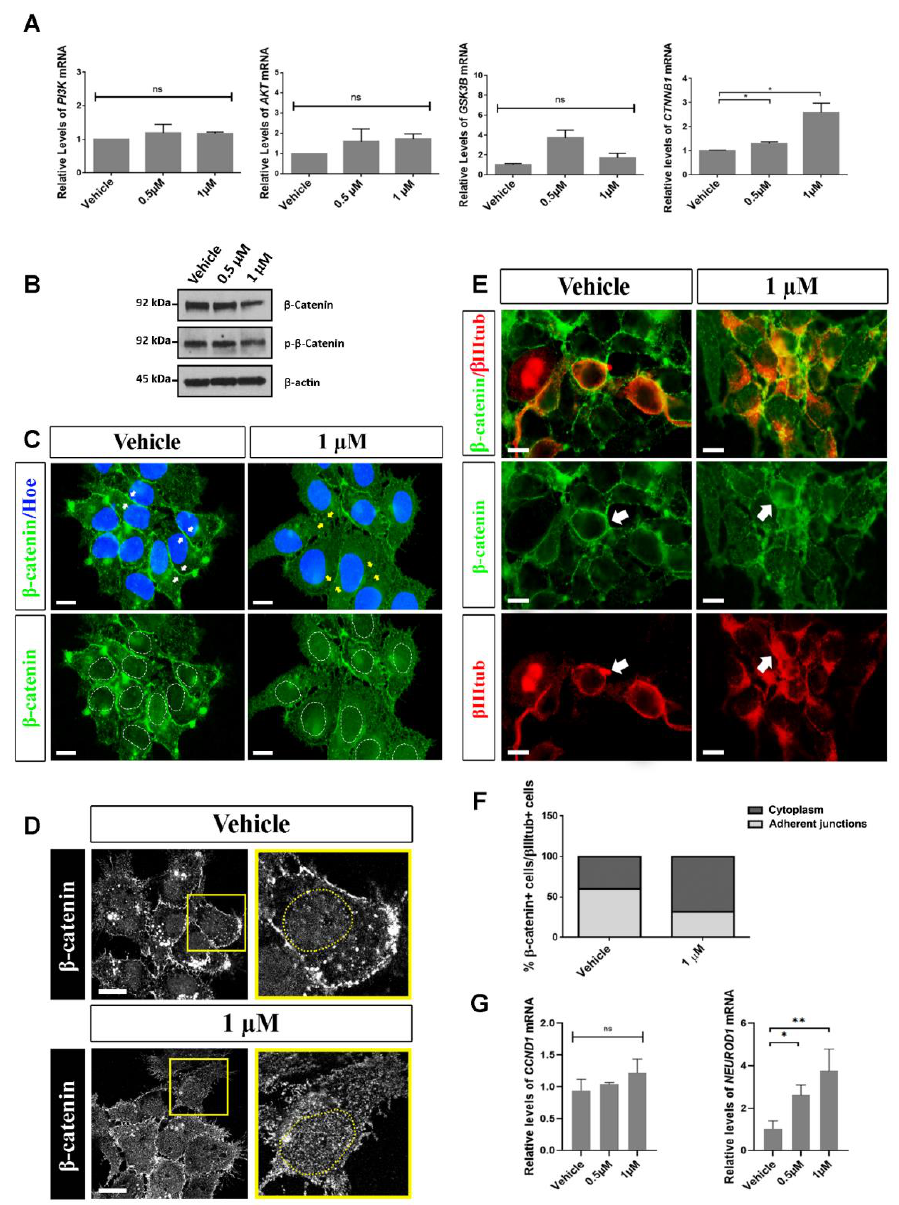
Figure 3. Change in β -catenin localization after treatment with the A β 40 peptide in differentiating hNS1 cells. ( A ) Relative expression levels of PI3K mRNA, AKT mRNA, GSK3B mRNA and CTNNB1 mRNA obtained by RT-qPCR analysis after treatment with the A β 40 peptide. ( B ) WB analysis of the expression of β -catenin (92 kDa) and p- β -catenin (92 kDa) in cellular extracts after A β 40 treatment. β -actin was used as a loading control (45 kDa). ( C ) Representative images showing β -catenin immunoreactivity (green) after A β 40 peptide treatment for 2.5 days. Cell nuclei were counterstained by Hoechst (blue). The localization of β -catenin in adherent junctions is higher in the vehicle group (white arrows) than the 1 µ M group (yellow arrows). ( D ) Representative images showing β -catenin immunoreactivity obtained by confocal microscopy. ( E ) Representative images showing double-immunoreactivity for β -catenin (green) and β -III-tubulin ( β IIItub; red) after A β 40 peptide treatment (arrows). Scale bar, 10 µ m. ( F ) Percentage of β -catenin+ cells/ β -III-tubulin+ cells (with immunoreactivity for β -catenin localized in cytoplasm or adherent junctions) after treatment with the A β 40 peptide. ( G ) Relative expression levels of CCND1 mRNA and NEUROD1 mRNA obtained by RT-qPCR analysis after A β 40 peptide treatment. Data are represented as the mean ± SD of at least three different experiments ( n = 3). Statistical significance of one-way ANOVA with post hoc Tukey’s test; * p < 0.05 and ** p < 0.01; ns = not